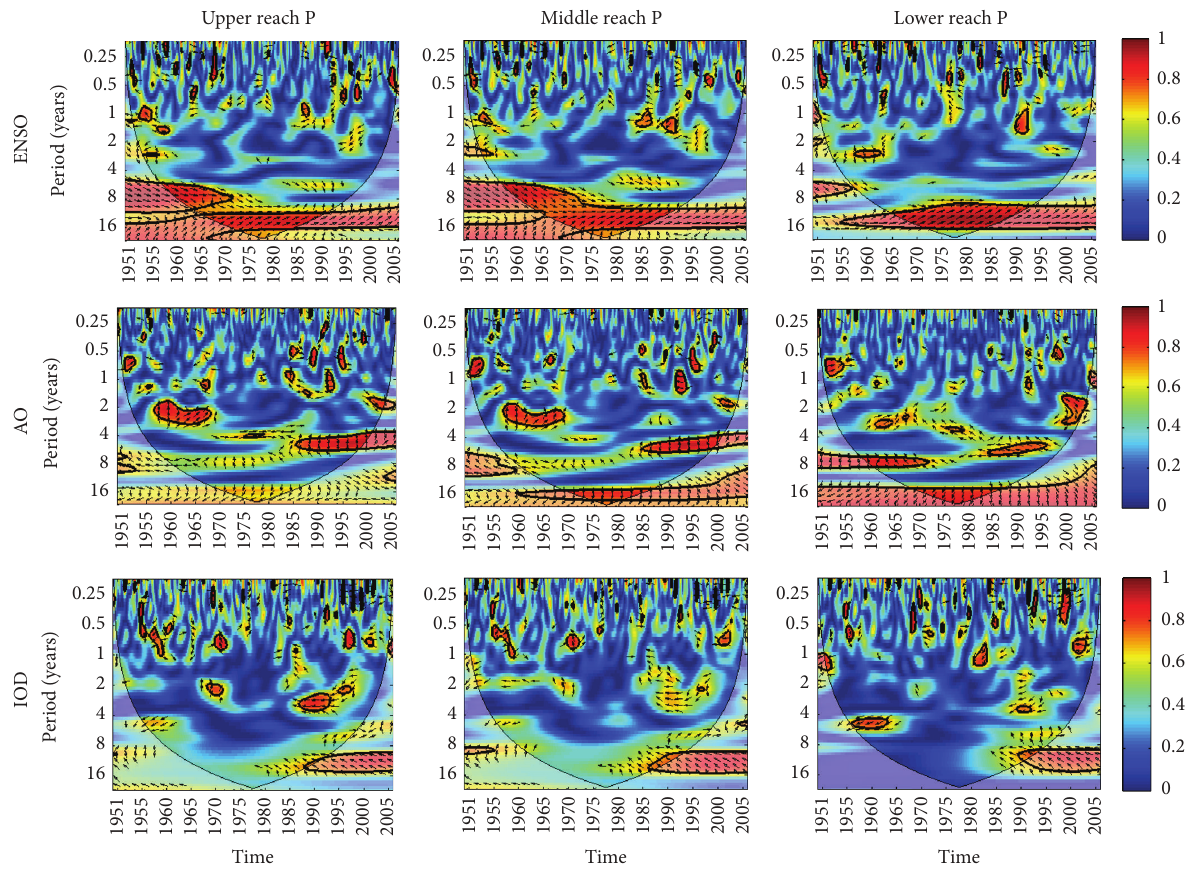
Figure 7: Wavelet coherence between climate signal (ENSO, AO, and IOD) and precipitation (in the upper, middle, and lower reaches) of the Heihe River basin. The thick contour indicates the 95% confidence level against red noise. The relative phase relationship is shown as arrows (with in-phase pointing right, antiphase pointing left, ENSO leading precipitation by 90 ∘ pointing straight down, and precipitation leading ENSO pointing straight